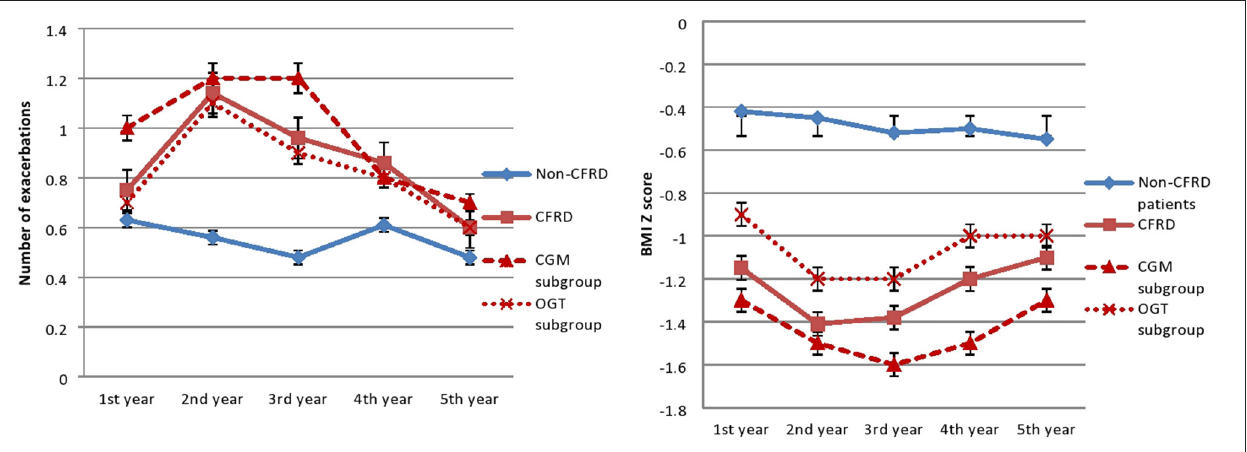
FIGURE 1 | Number of exacerbations and BMI Z-score. In the CFRID group the number of exacerbations significantly decreased ( p = 0.02), and BMI Z-score significantly improved ( p = 0.04) after initiating insulin therapy in the third year of